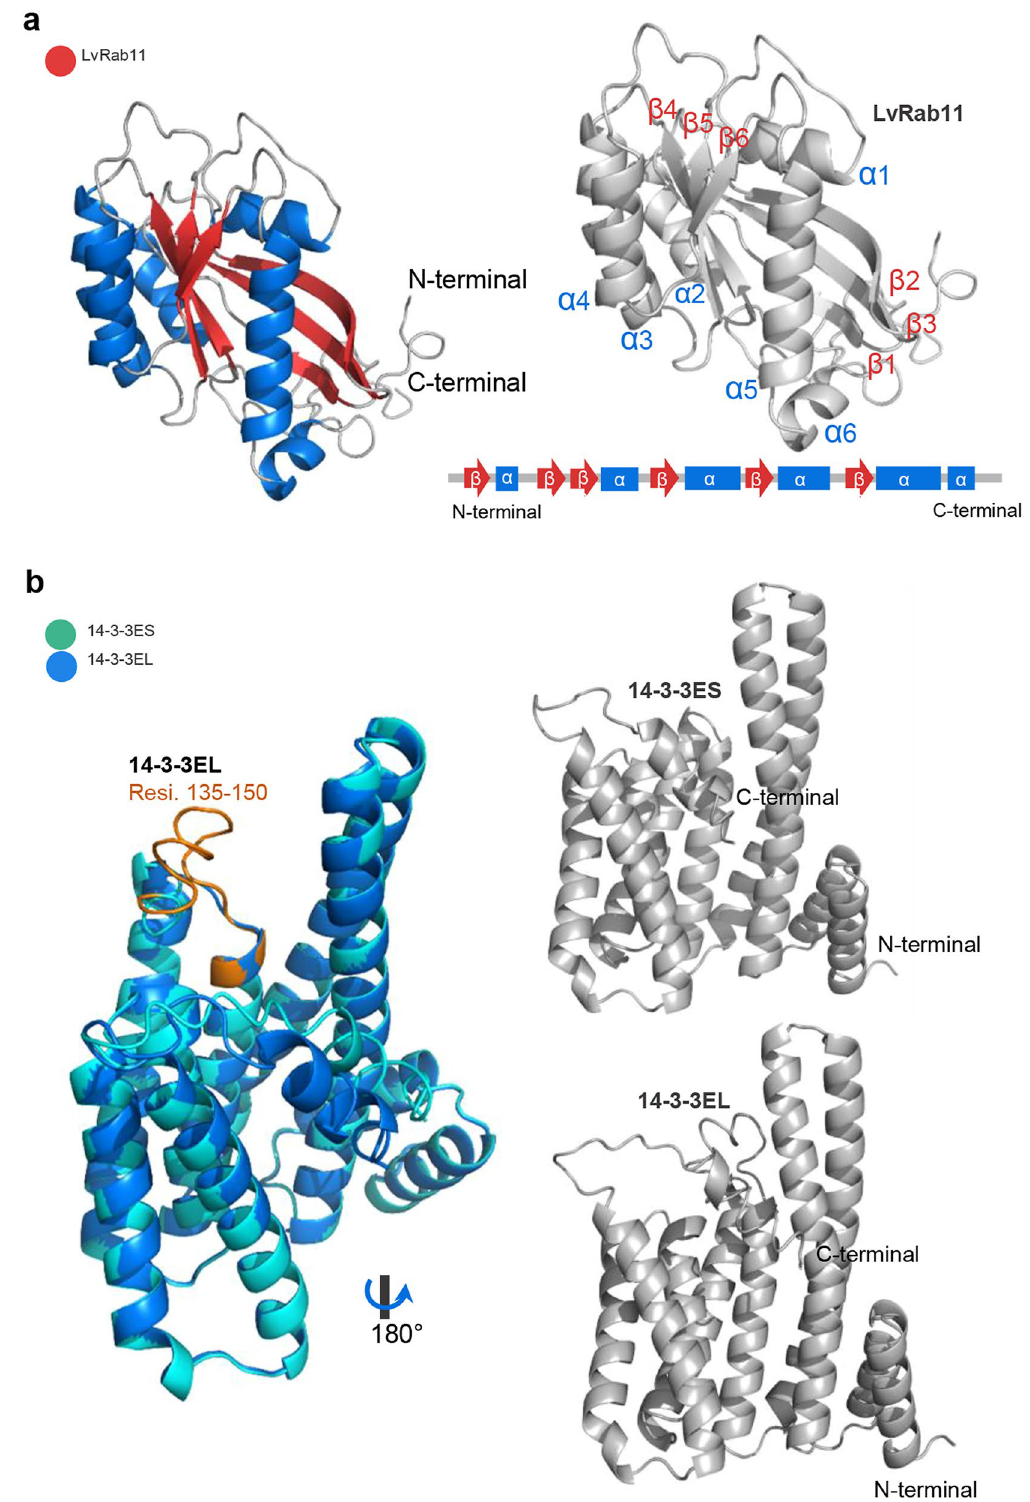
Figure 2. Predicted 3D structure of 14-3-3 and LvRab11. A 3D structure model of hub binding proteins was generated from the primary amino acid sequence by using homology modelling on the SWISS-Model server 11–13 combined with threading-based LOMETS on the I-TASSER server 14–16 and the pDomTHREADER search method on the PSIPRED server 17,18 . ( a ) The cartoon structure presenting the predicted model of LvRab11. ( b ) Predicted structure of 14-3-3 isoforms, where 14-3-3EL is coloured blue-marine and 14-3-3ES is coloured turquoise. The insertion residues of 14-3-3ε found at amino acid residues 135–150 in the 14-3-3EL are coloured in the orange